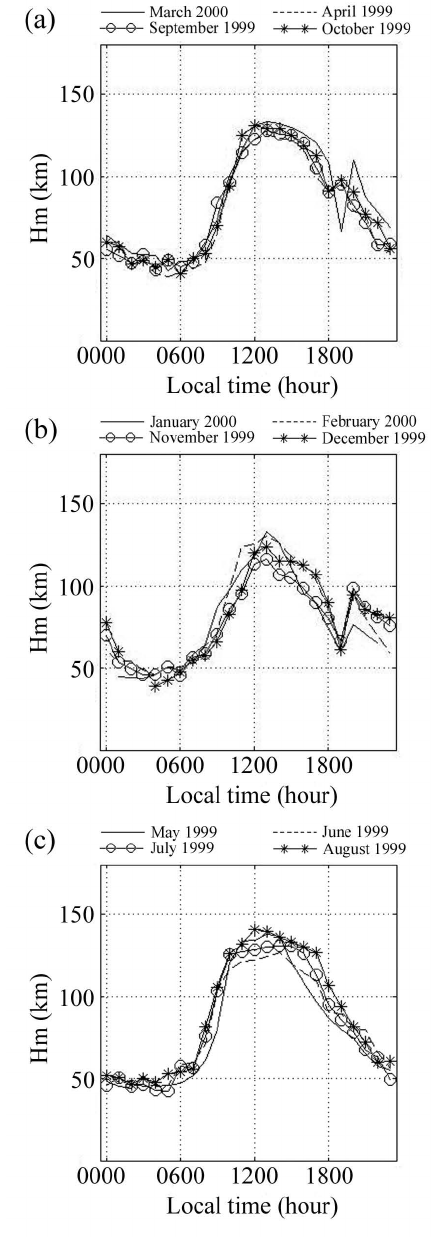
Fig. 2. The quiet-condition monthly median values of Hm for the (a) equinoctial, (b) summer, and (c) winter months during April 1999–March 2000.